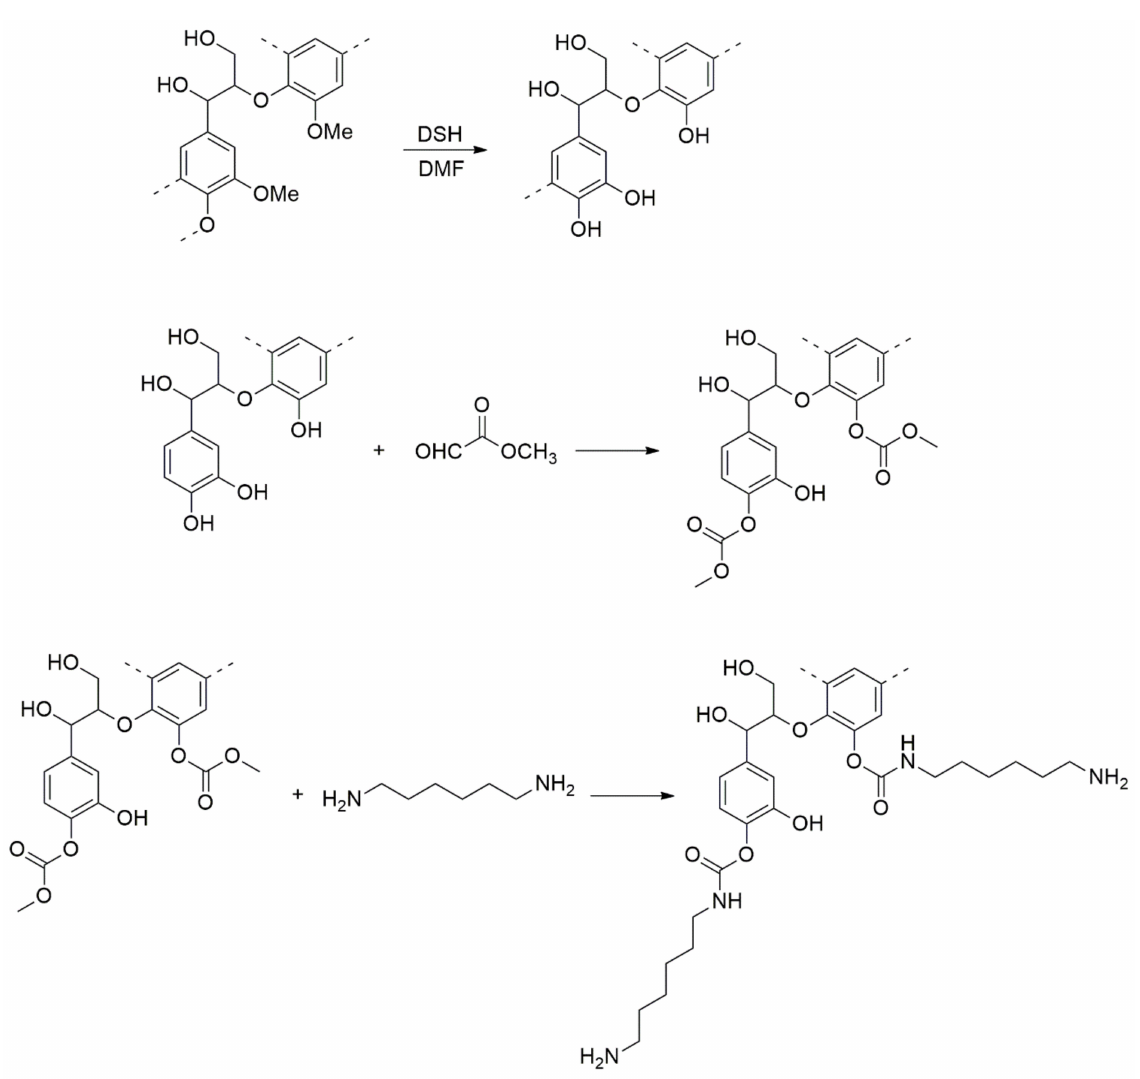
Figure 6. Possible pathway for reaction of lignin-based NIPUs by demethylation and carbonation